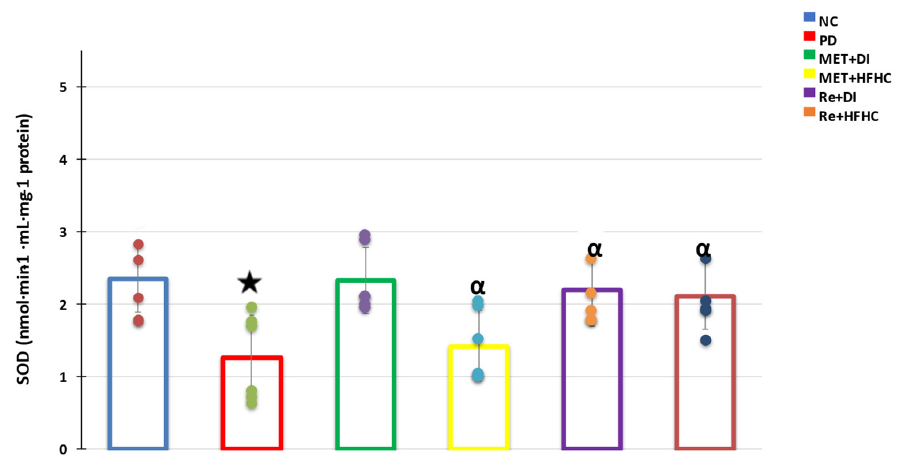
Figure 6. SOD activity in normal control (NC), prediabetic control (PD), metformin and diet intervention (MET + DI), metformin and high fat–high carbohydrate (MET + HFHC), rhenium (V) compound and diet intervention (Re + DI) and rhenium (V) compound and high fat–high carbohydrate (Re + HFHC) groups after 12 weeks of treatment. Values are presented as means ± SD and individual data points ( n = 6). (cid:63) p < 0.05 by comparison with NC, α p < 0.05 by comparison with PD, MET + DI, MET + HFHC, Re + DI and Re + HFHC.